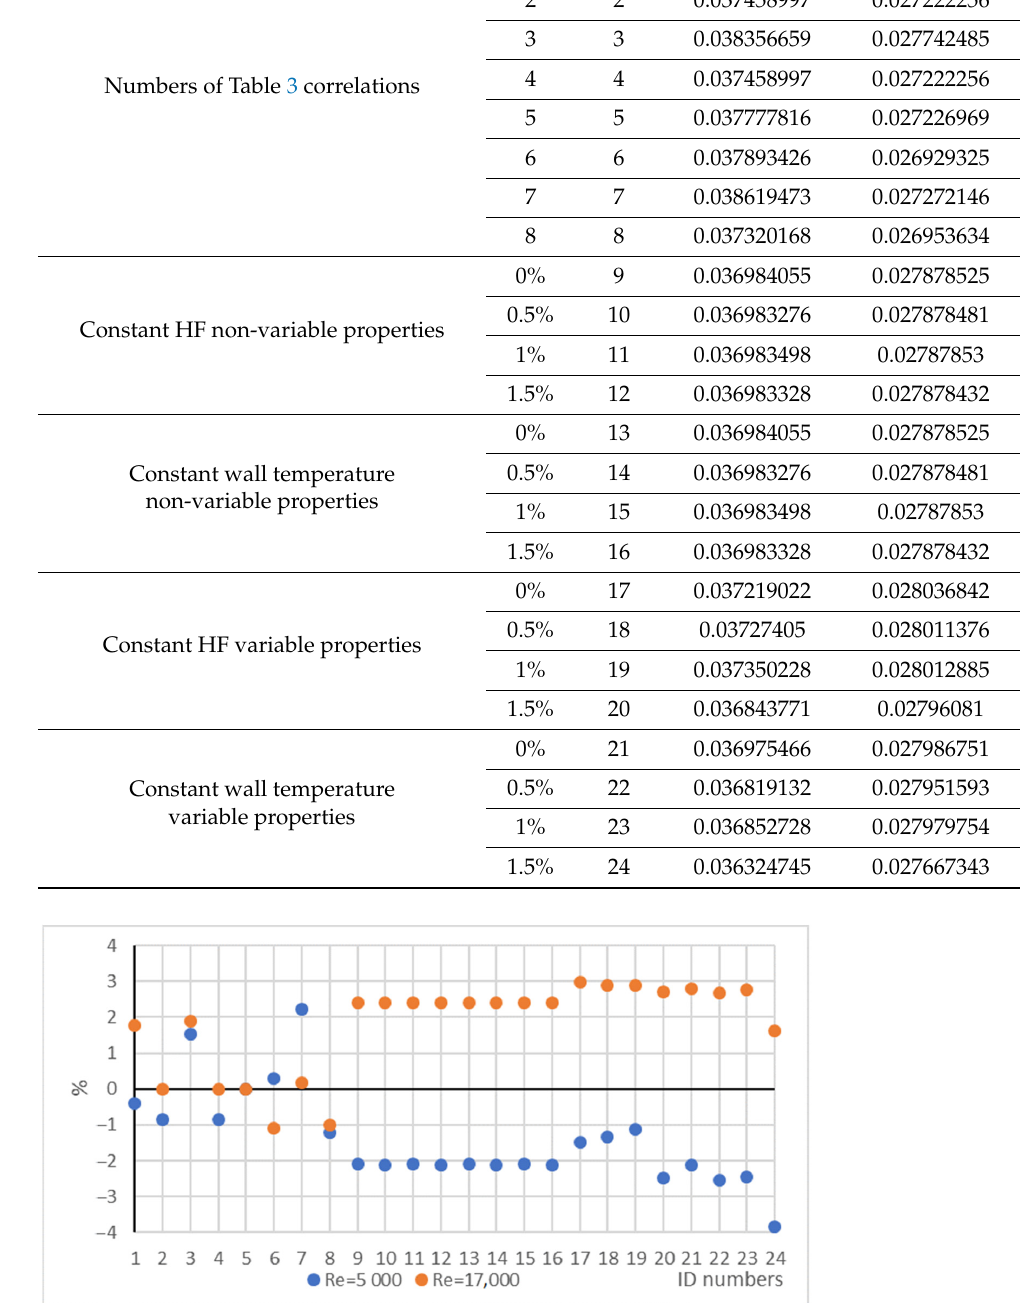
Table 9. The friction factors by different correlations and the CFD simulations.